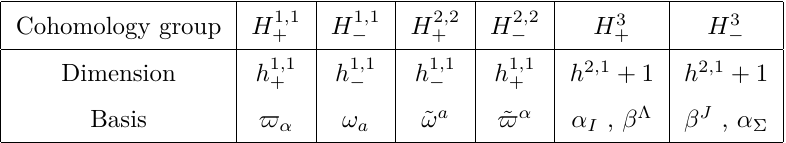
Table 1 . Representation of various harmonic forms and their